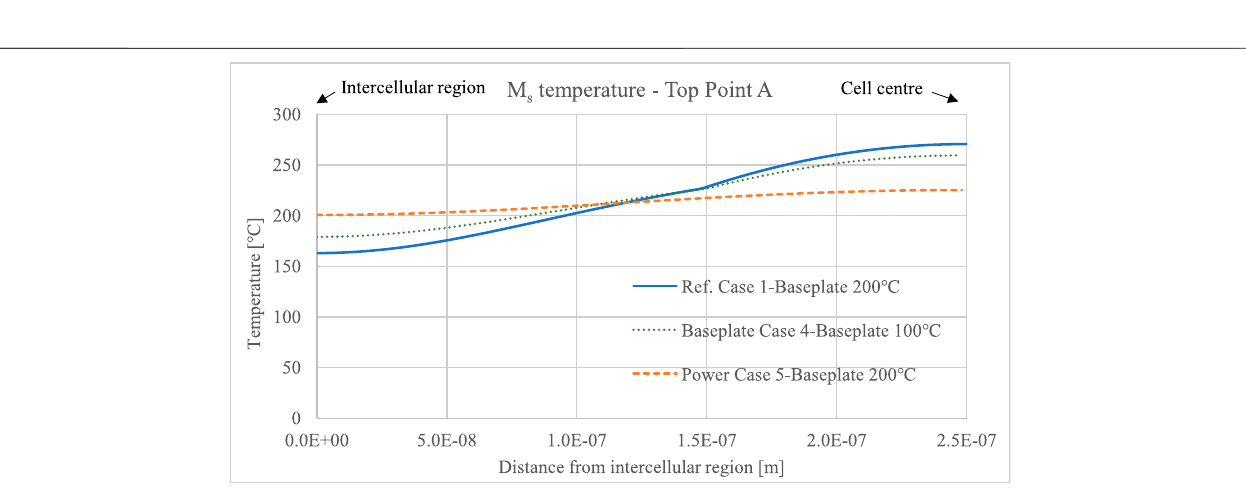
Frontiers in Materials |